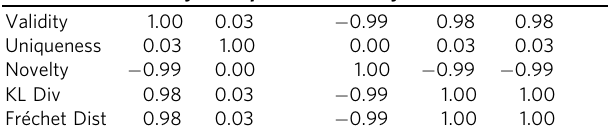
Table 2 Spearman ’ s correlation coef fi cient between benchmark metrics for results using LSTM, Transformer Small and Transformer Regular on the QM9